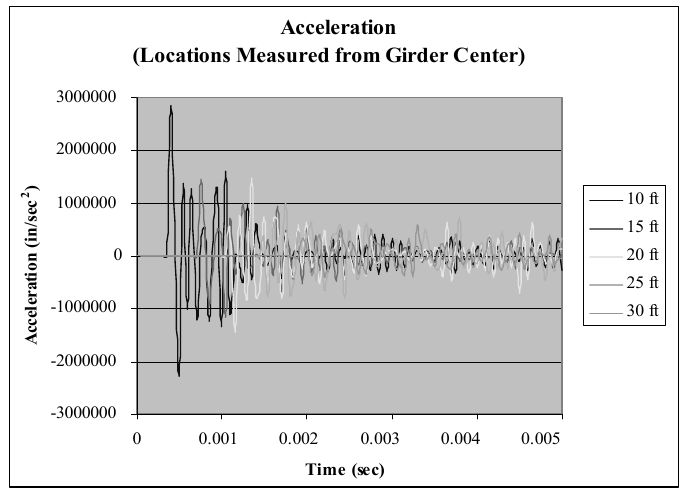
Fig. 16. Acceleration for blast below the